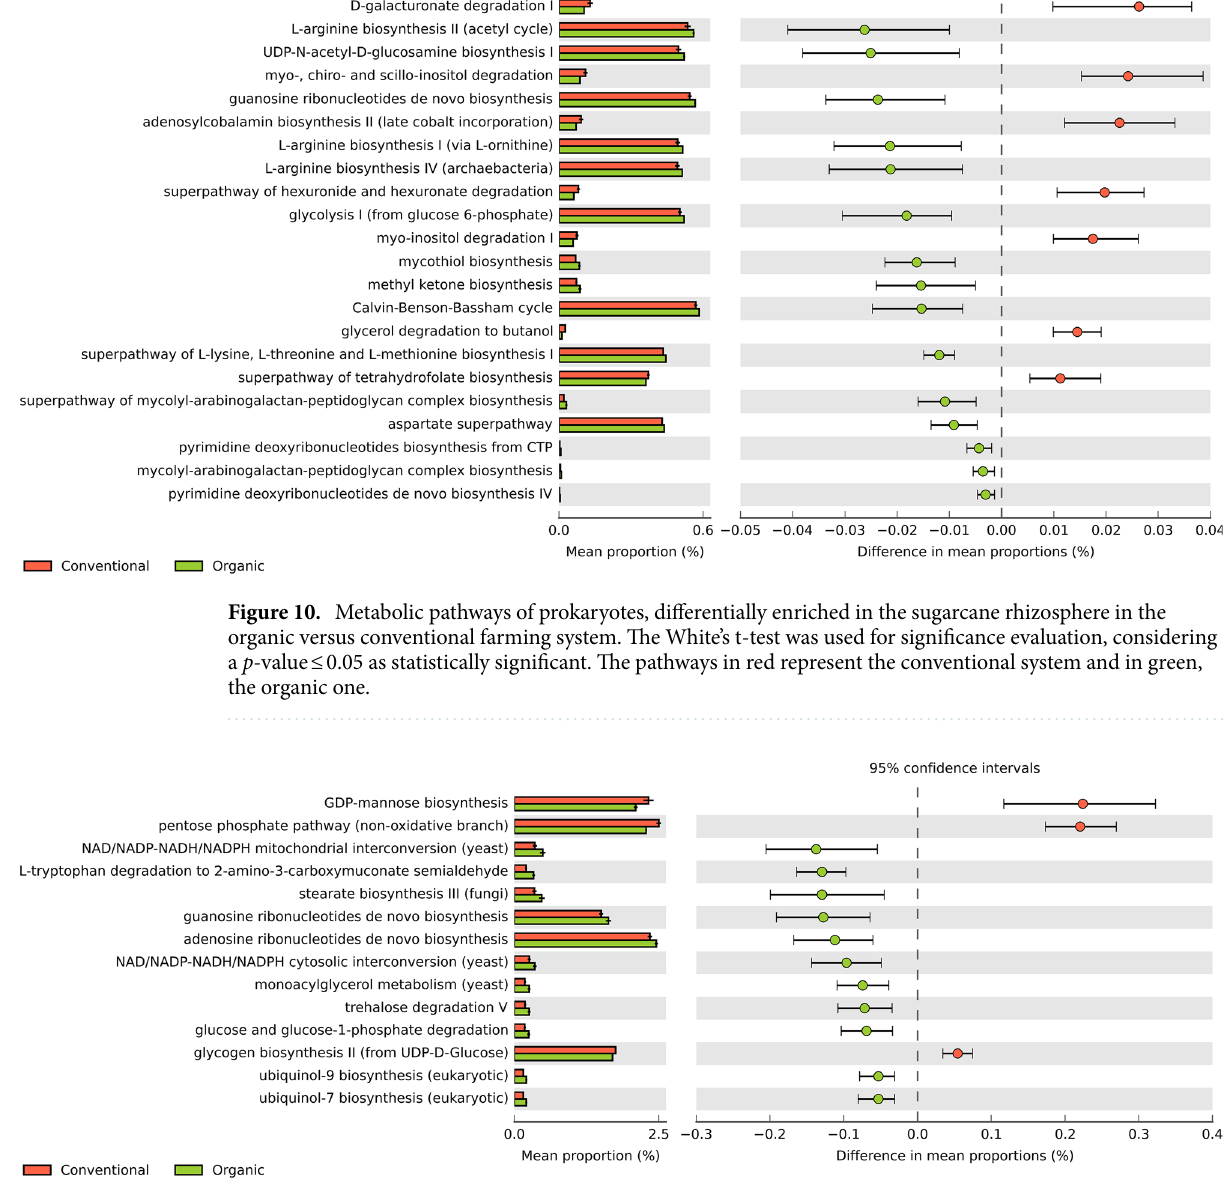
Figure 11. Metabolic pathways of fungi, differentially enriched in the sugarcane rhizosphere in the organic versus conventional farming system. The White’s t-test was used for significance tests, considering a p -value ≤ 0.05 as statistically significant. The pathways in red represent the conventional system and in green, the organic